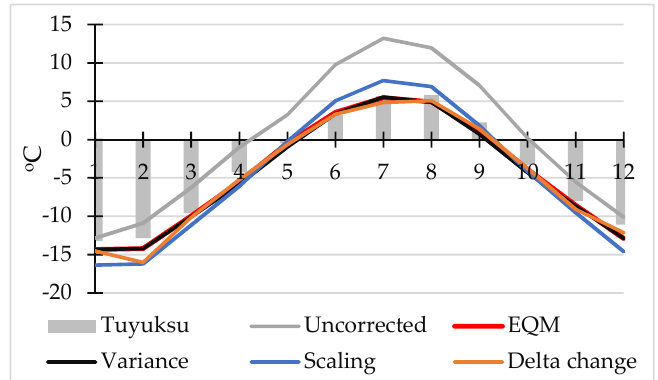
Figure 3. Comparison of bias correction methods applied to the simulations of air temperature for the baseline period. PRECIS simulations driven by ECHAM5 are used as example.